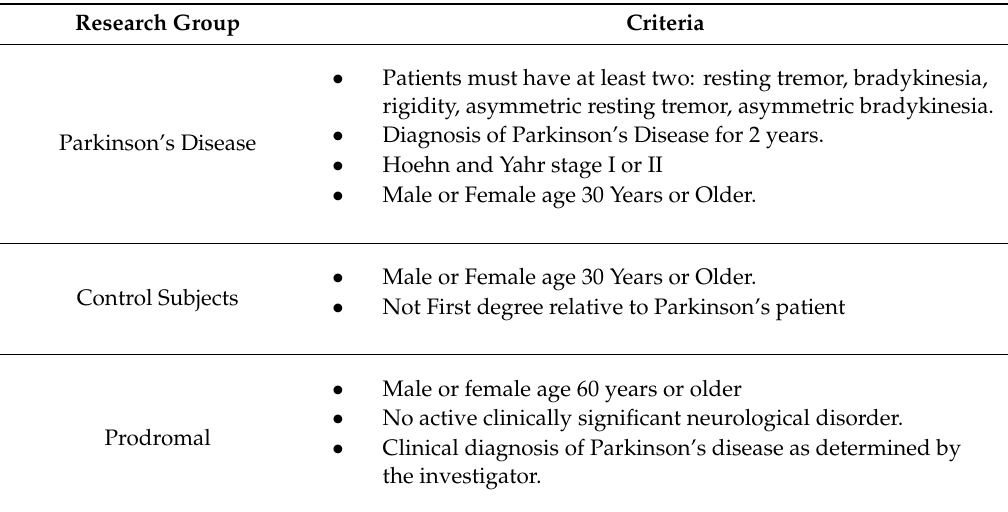
Table 2. Eligibility Criteria for the Subject to be included in a Research